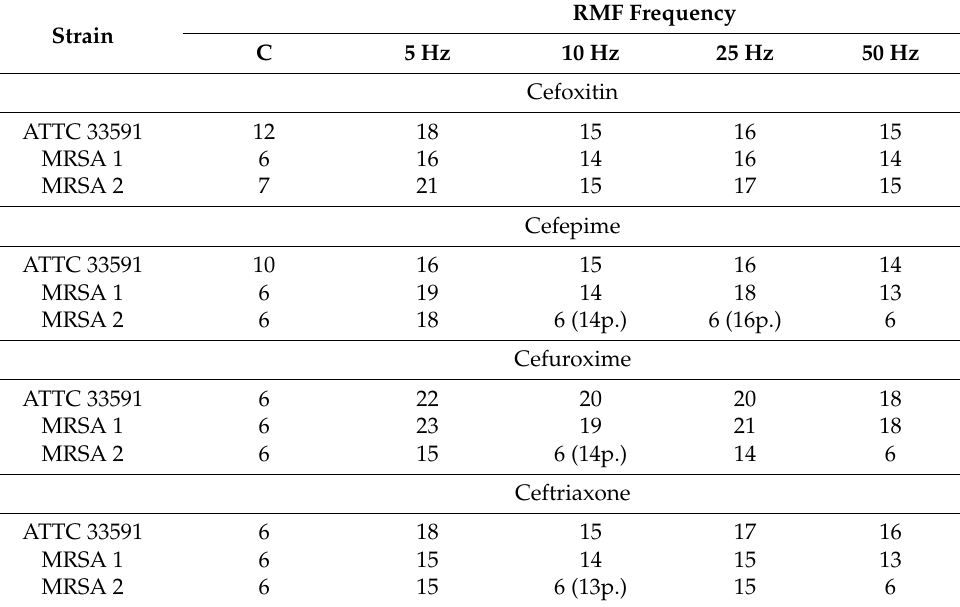
Table 1. Growth inhibition zones (mm) of MRSA strains around discs with β -lactam antibiotics depending on RMF frequency